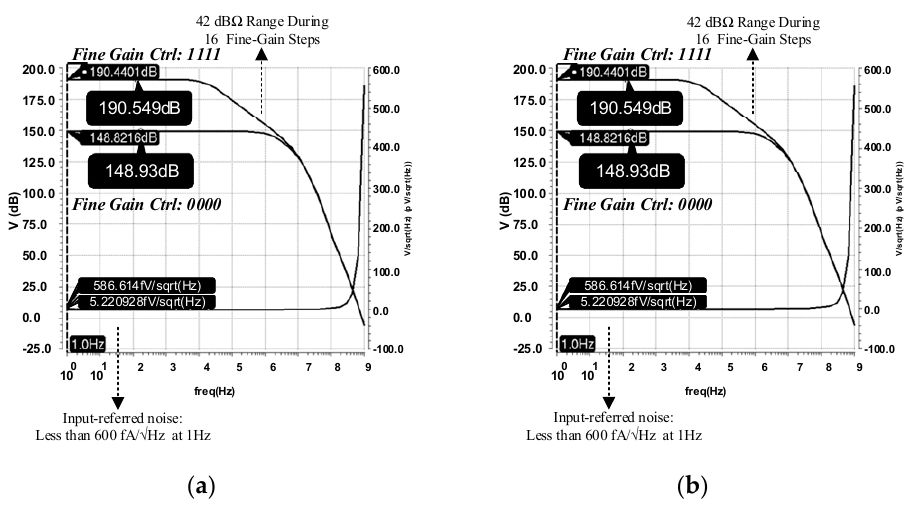
Figure 9. The simulation results of the ( a ) fine-gain and ( b ) course-gain modes.